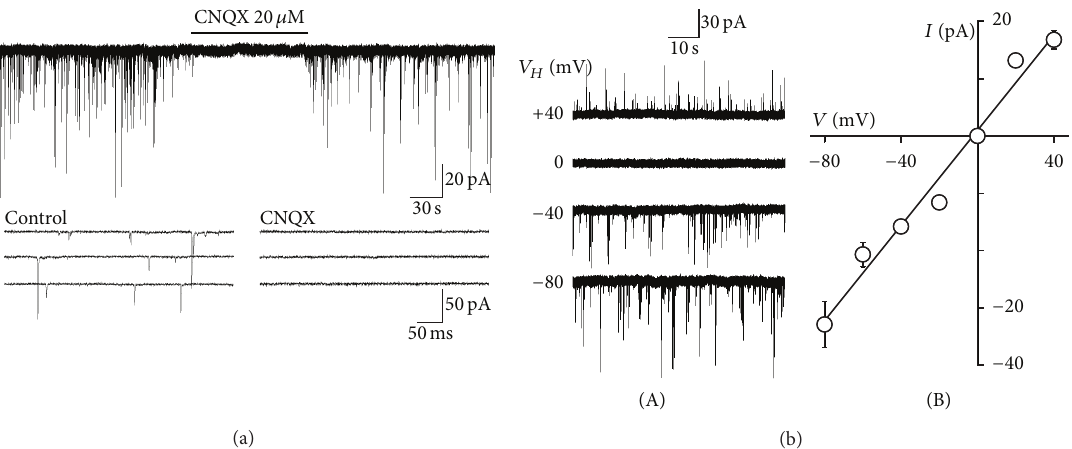
Figure 1: Glutamatergic sEPSCs recorded from acutely isolated PAG neurons. (a) A typical trace of glutamatergic sEPSCs observed before, during, and after application of 20 𝜇 M CNQX, an AMPA/KA receptor blocker, at a V 𝐻 of 0 mV in the presence of 10 𝜇 M SR95531 and 50 𝜇 M APV, selective GABA A , and NMDA receptor antagonists, respectively. Insets represent typical traces with an expanded time scale. (b) (A) ). (B) A plot of the mean amplitude of sEPSCs at various 𝑉 values. Typical traces of glutamatergic sEPSCs at various holding potentials ( 𝑉 H H The reversal potential was − 2.5 mV, which is close to the theoretical equilibrium potential of monovalent cations. Each point was the mean and SEM from the 4